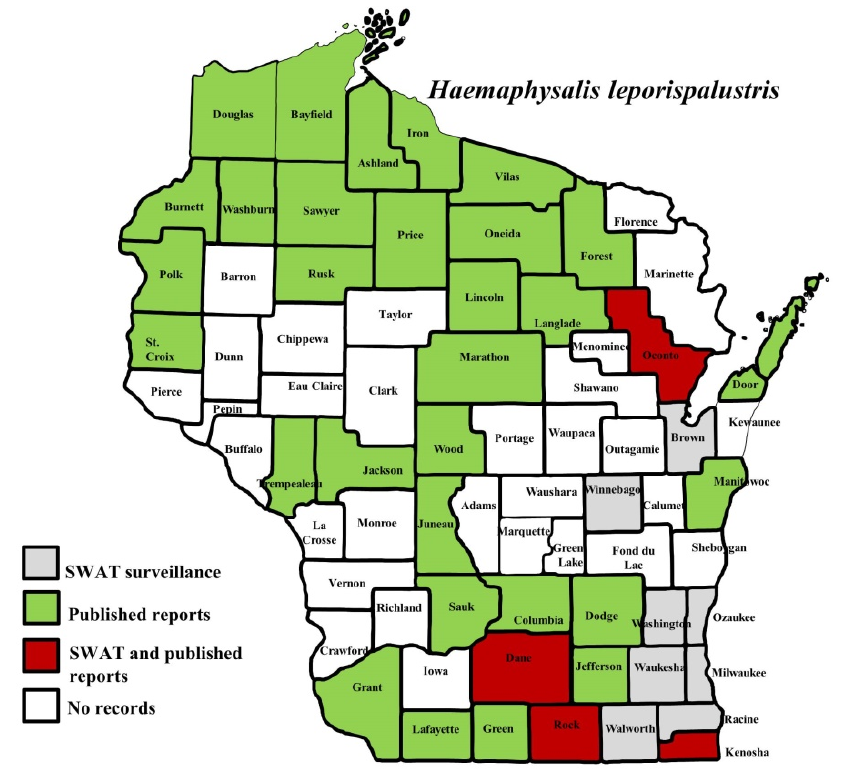
Figure 5. County records for Haemaphysalis leporispalustris in Wisconsin [18,27,28].